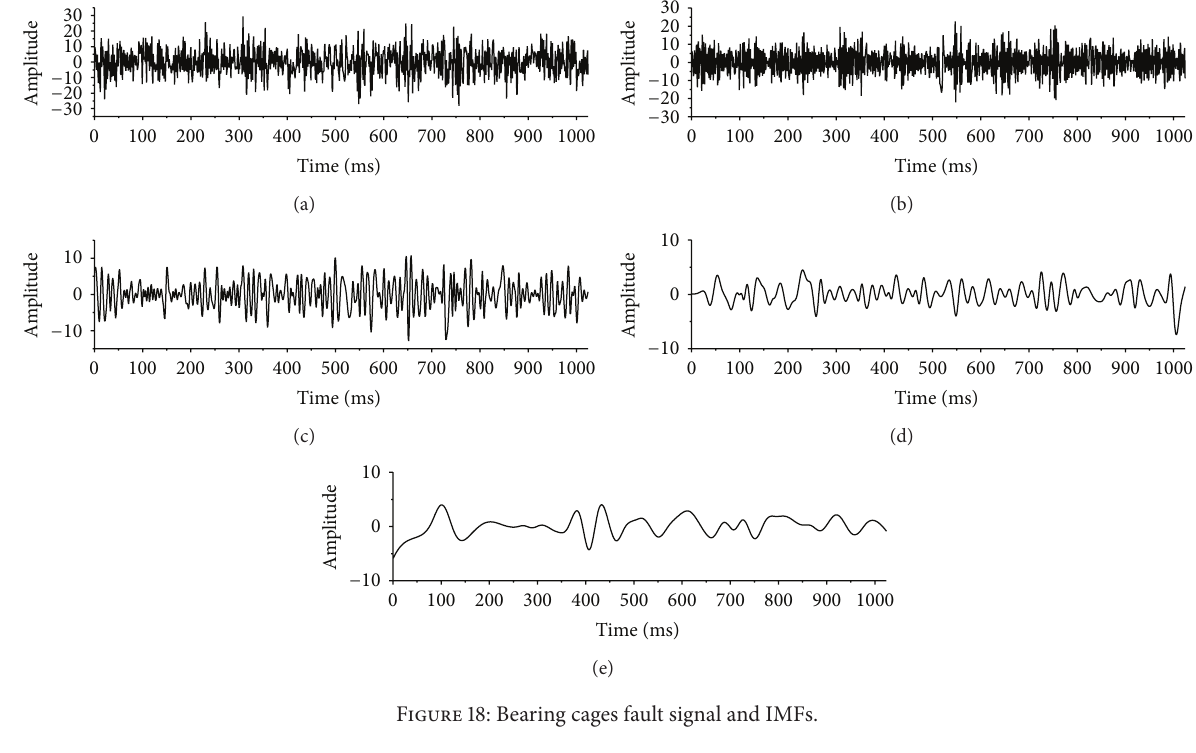
Figure 18: Bearing cages fault signal and IMFs.